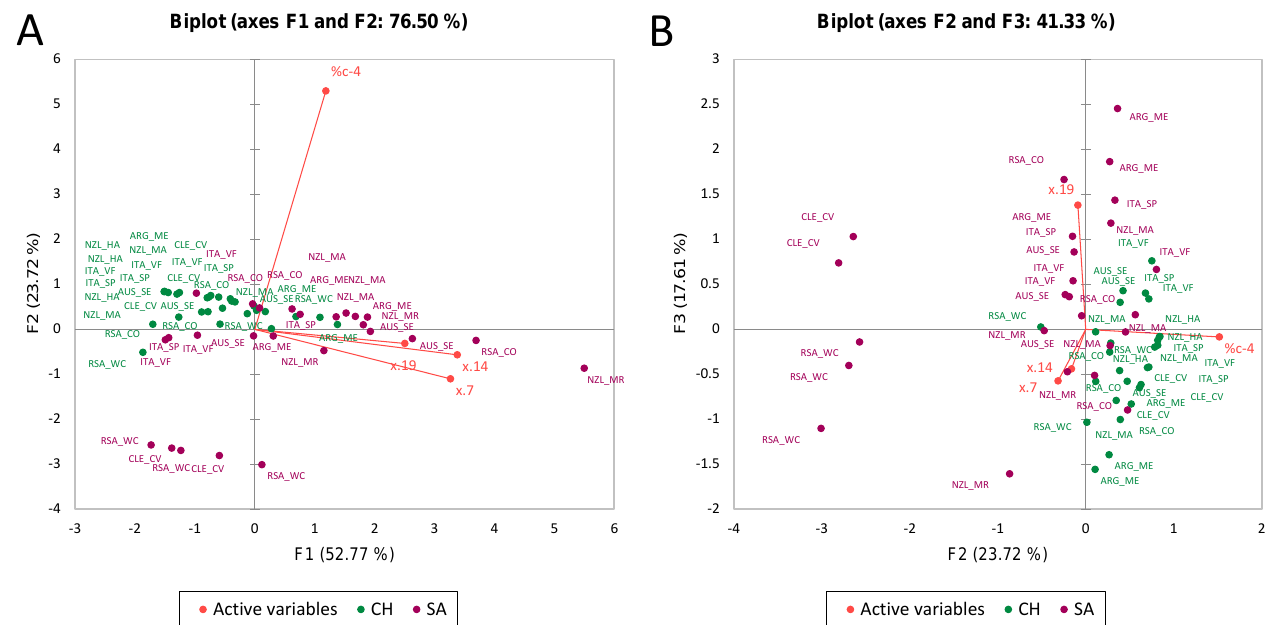
Figure 11. Biplot on PAC data for Chardonnay ( A ) and Sauvignon Blanc ( B ) wines. Supplementary variables (projected in blue) were obtained from the most significant ones in the ANOVA. Table 10. ANOVA results for significant proanthocyanidins (PAC) differentiating Chardonnay and Sauvignon Blanc with the PAC. a and b letters represent groupings computed by Tukey’s post-hoc test.